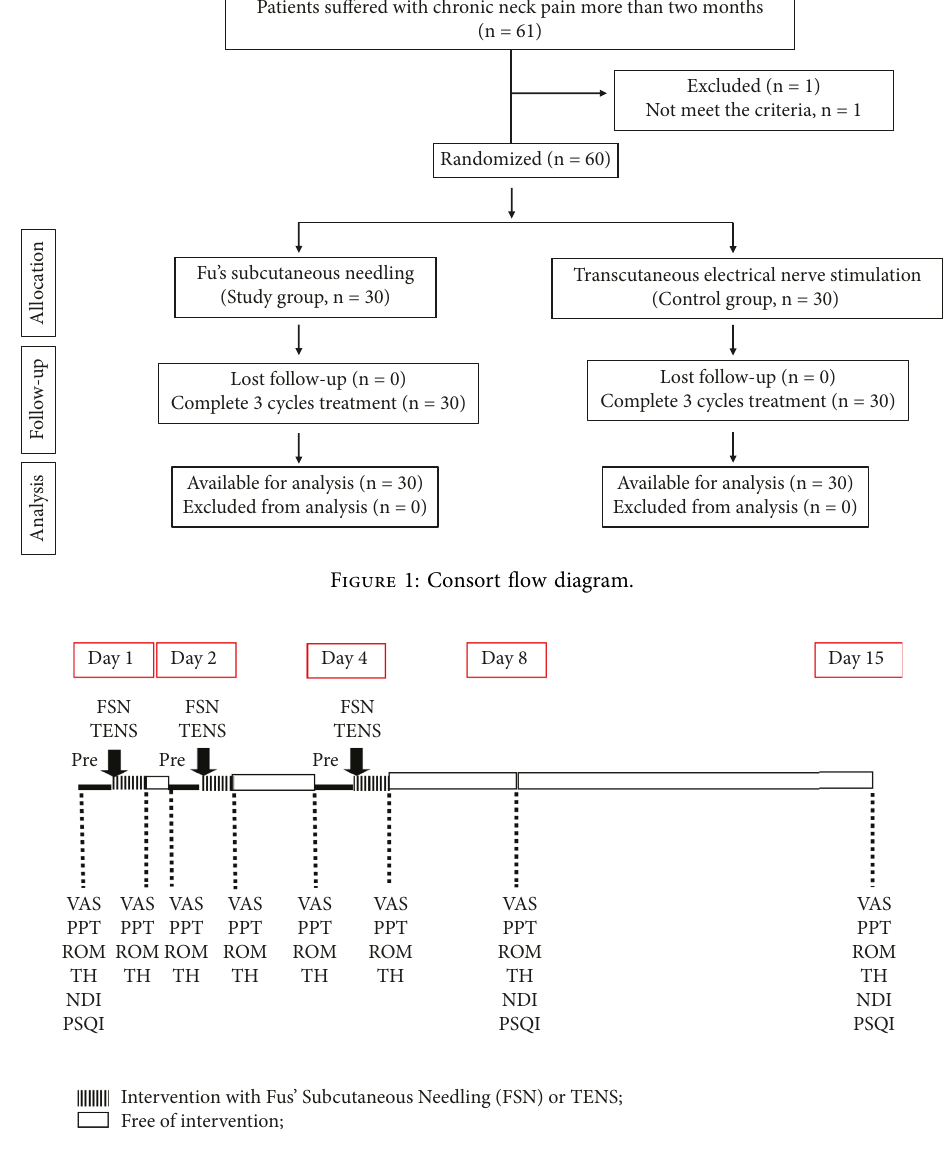
Figure 2: Study design. All participants were treated with FSN or TENS as described in Materials and Methods. Pre: before intervention; FSN: Fu’s subcutaneous needling; TENS: transcutaneous electrical nerve stimulation; VAS: visual analog scales; PPT: pressure pain threshold; ROM: active neck range of motion; TH: tissue hardness; NDI: neck disability index; PSQI: Pittsburgh sleep quality